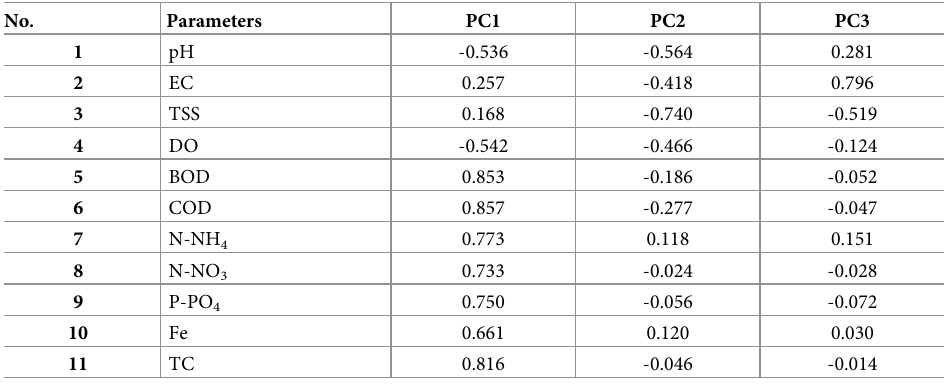
Table 3. Factor loadings for the variables on the first three principal